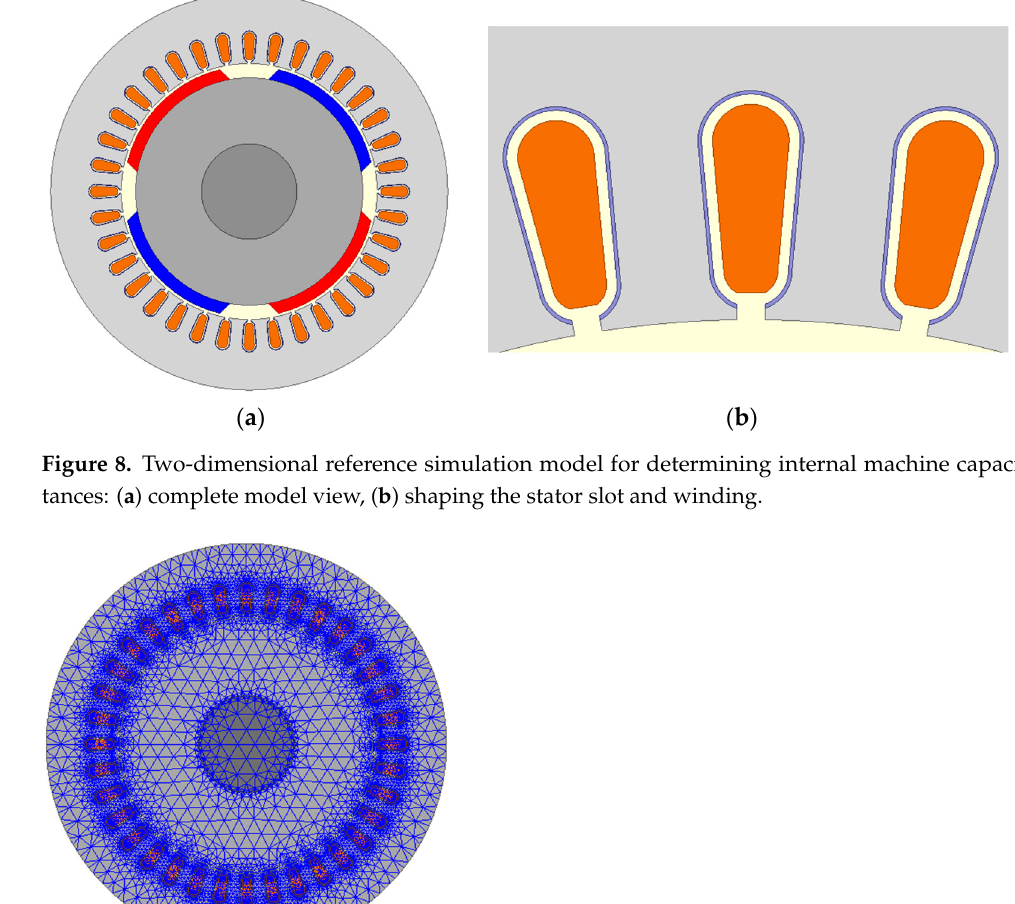
Figure 10. The shape of the analyzed stator slot with the marked opening width B s0 .